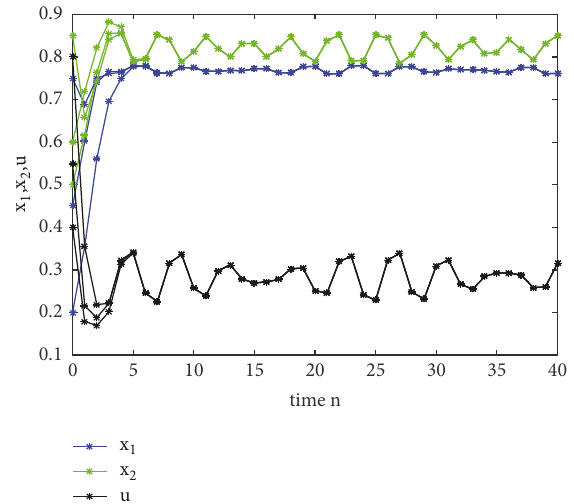
Figure 1: Dynamic behaviors of the solutions (𝑥 1 (𝑛),𝑥 2 (𝑛),𝑢(𝑛)) of system (103) with the initial conditions (𝑥 1 (𝜃),𝑥 2 (𝜃),𝑢(𝜃)) = (0.2, 0.4, 0.6),(0.45, 0.5, 0.55),(0.75, 0.85, 0.8) for 𝜃 = ⋅⋅⋅ ,−𝑛,−𝑛 + 1, ⋅ ⋅ ⋅ ,−1, 0 ,